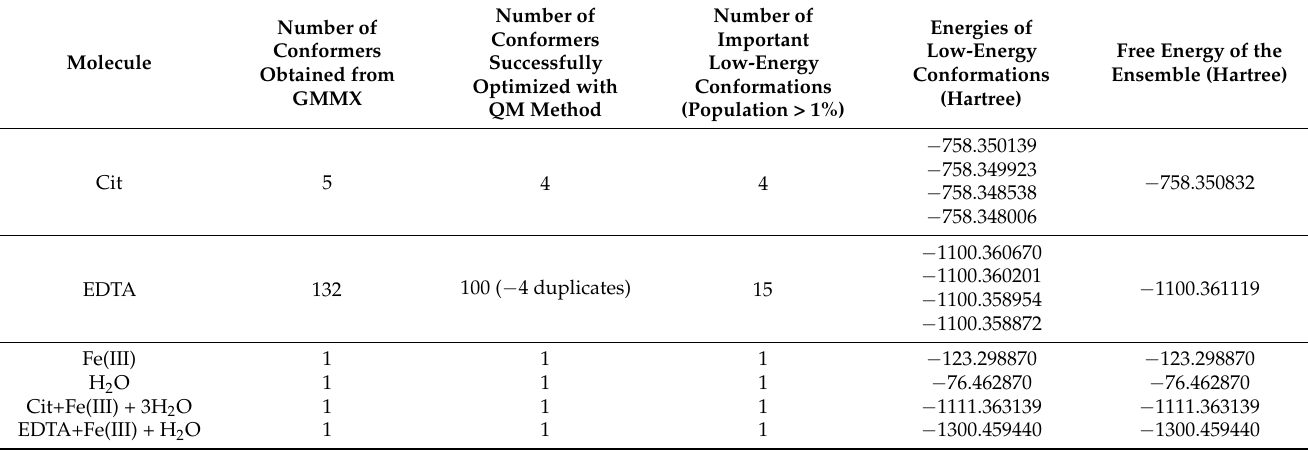
Table 4. Properties of all molecules calculated with B3LYP/6-311 + G(d,p)/IEF-PCM method.